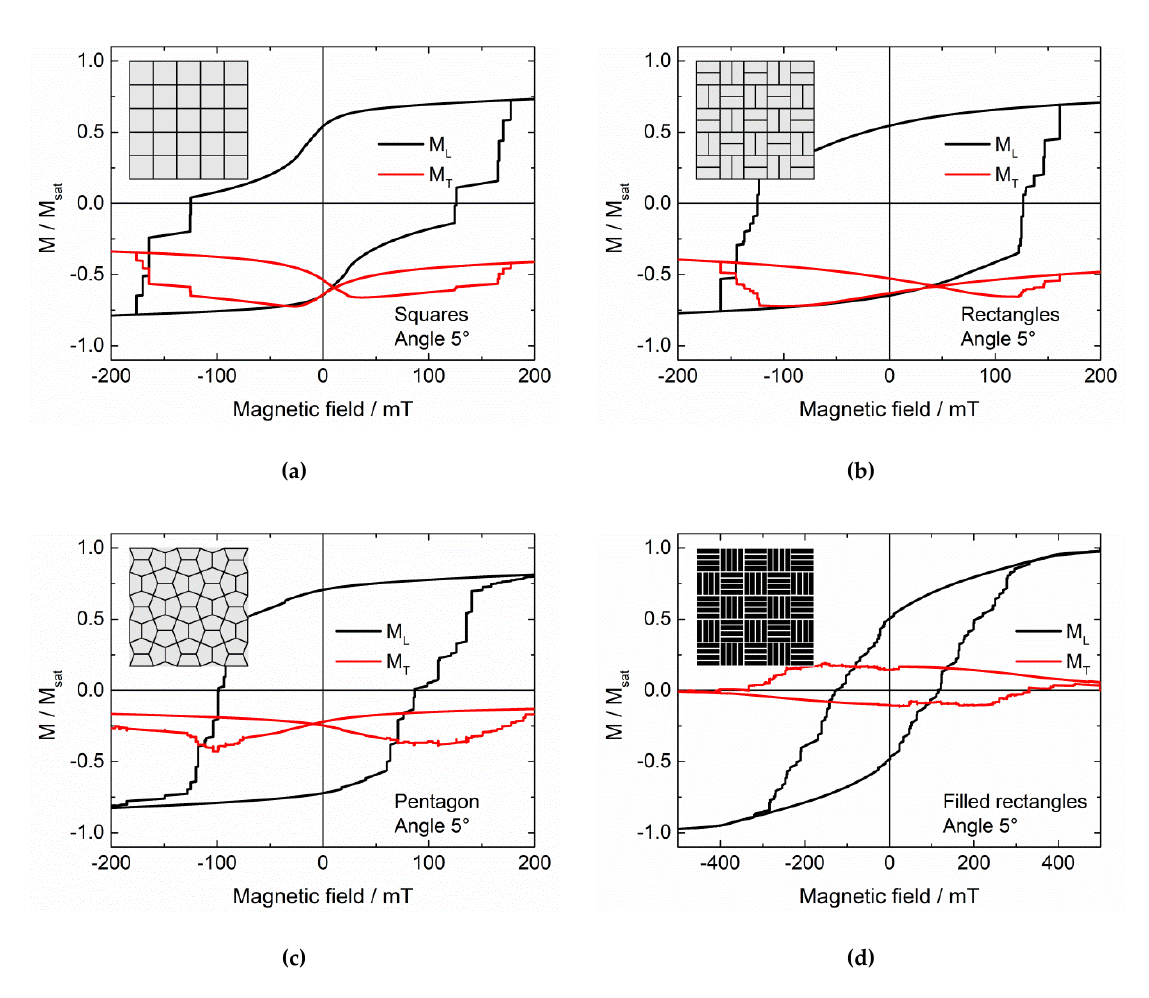
Figure 6. ( a – d ) Longitudinal and transverse hysteresis loops ML and MT, simulated for different tessellations (cf. insets) after setting a large magnetic field of 5 T.